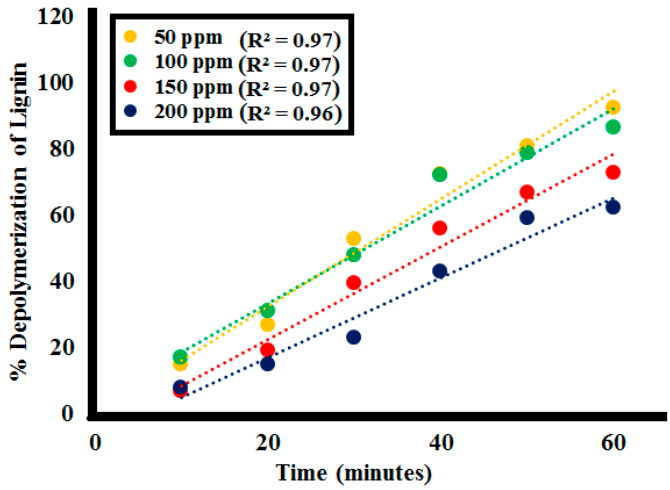
Figure 12. Correlation between %lignin ( L1 ) depolymerization of the different lignin concentrations by SK9 and the time intervals.